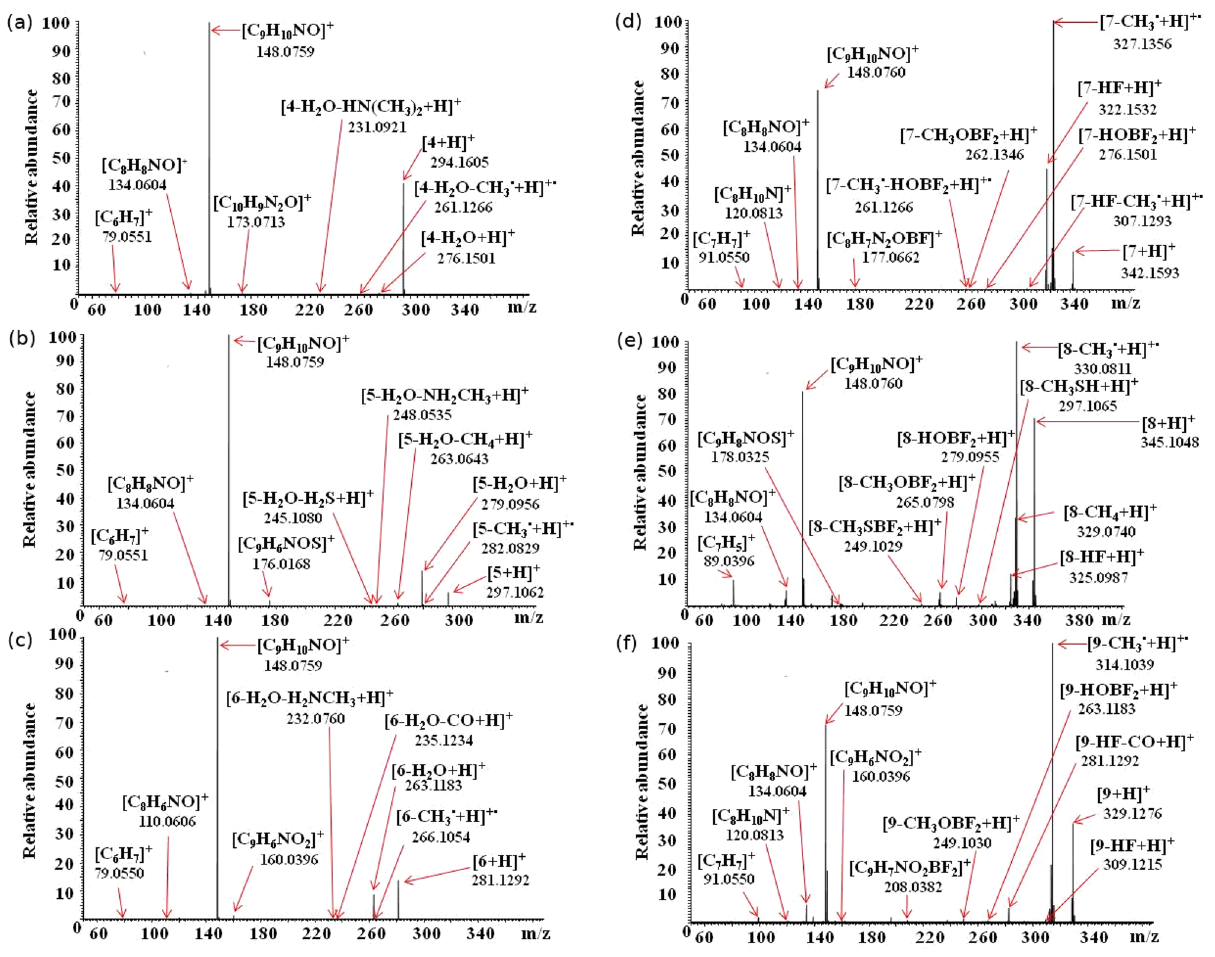
Figure 7. ESI HCD MS/MS mass spectra of singly charged ions [ 4 +H ] + ( a ), [ 5 +H ] + ( b ), [ 6 +H ] + ( c ), [ 7 +H] ( d ), [ 8 +H] ( e ) and [ 9 +H] ( f ). The values given under the molecular formulas correspond to the experimental masses of the generated products ions.